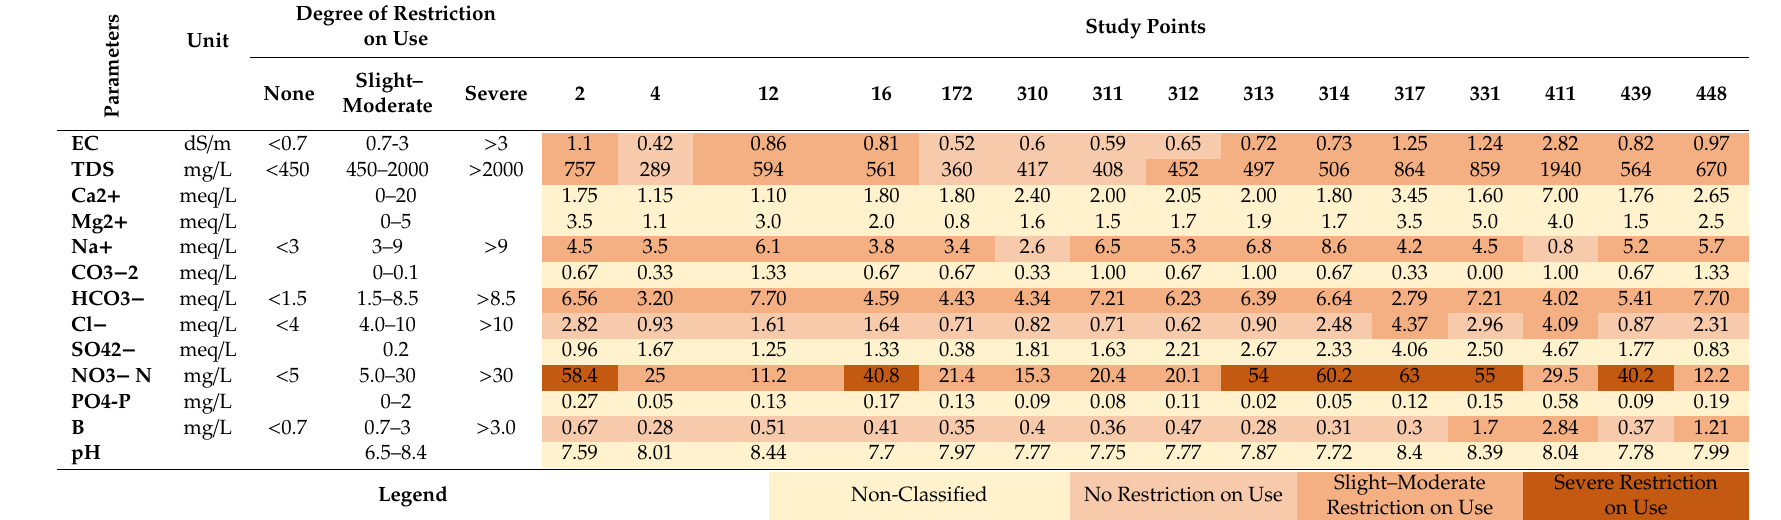
Table 11. Comparison of measured parameters with the usual range of them in irrigation water used from